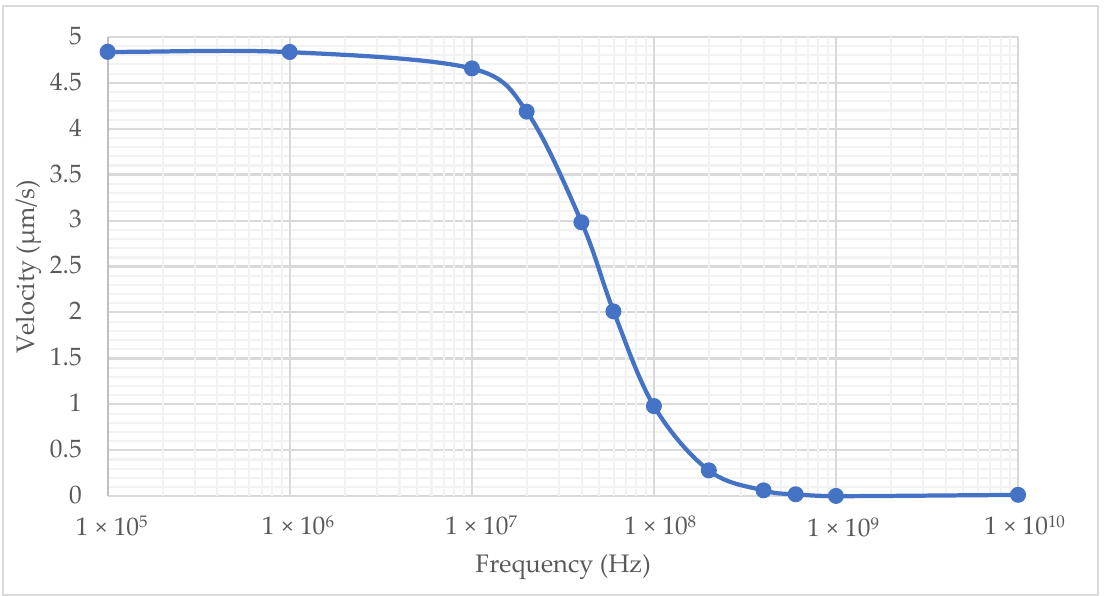
Figure 6. Frequency dependence of ACET fl ow rates at 5 V peak . The ACET fl ow rate remains rela- tively constant at lower frequencies but begins to drop o ff at around 10 MHz as the coulombic force quickly diminishes.